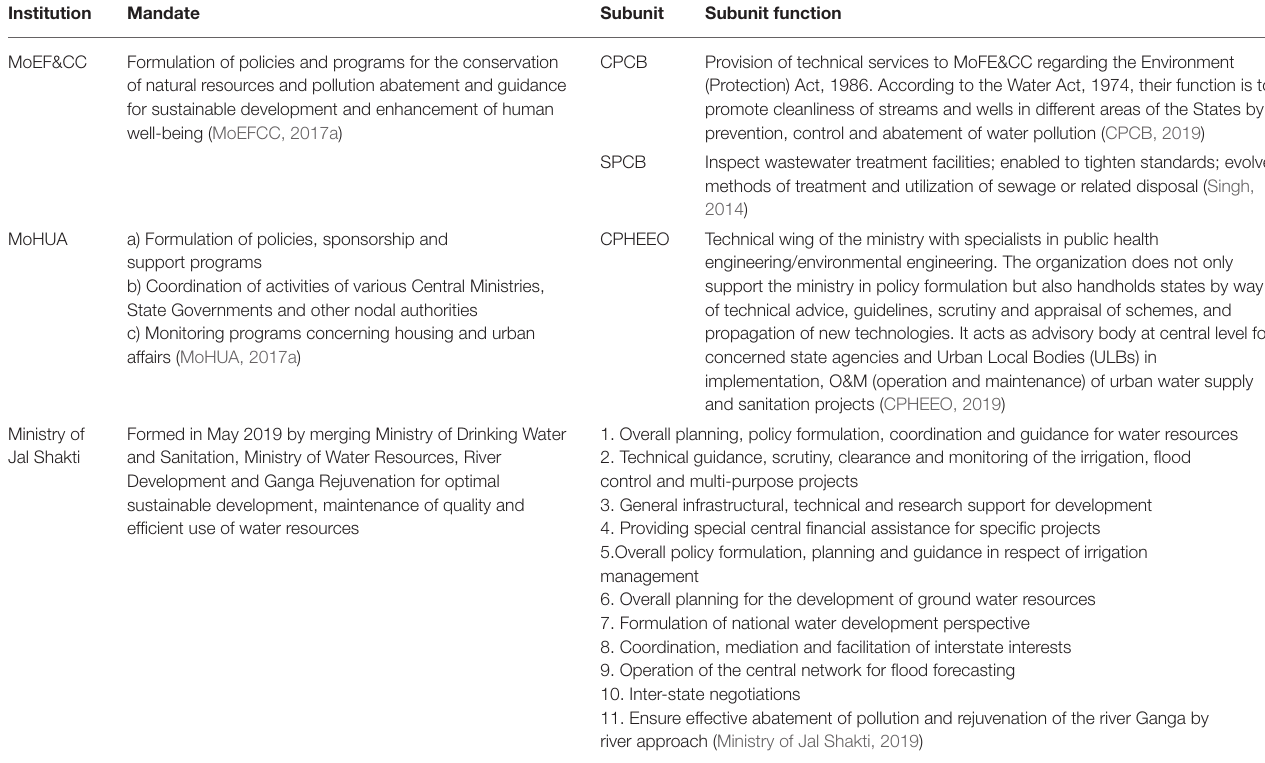
TABLE 2 | Institutional structure for setting wastewater discharge standards.